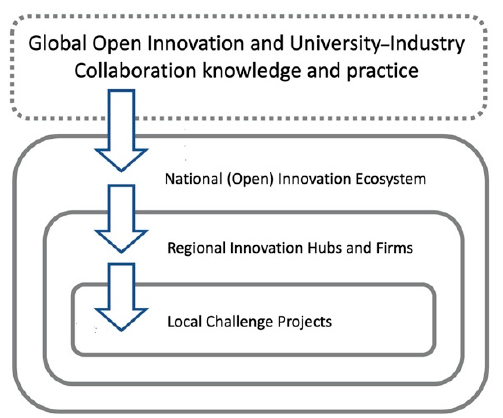
Figure 1. Open Innovation Ecosystem Framework.